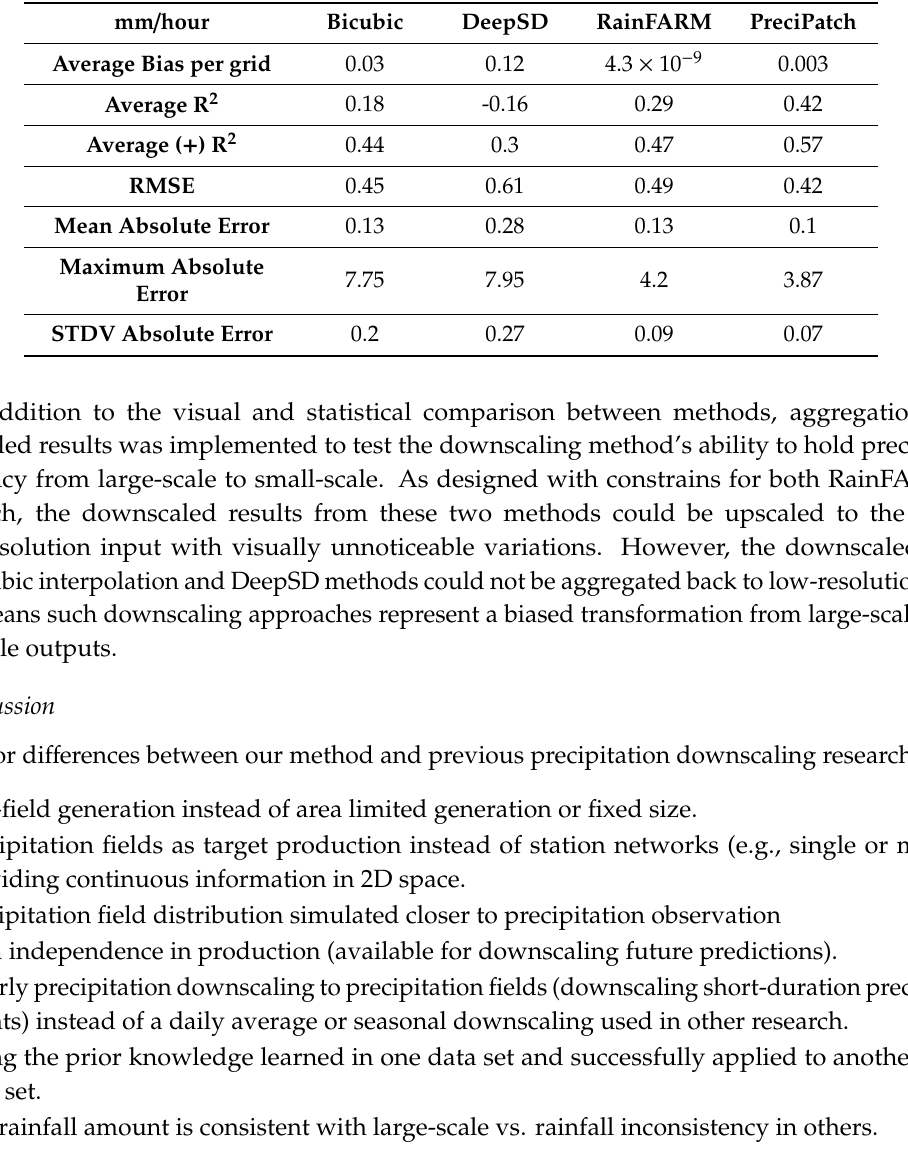
Table 9. Statistical